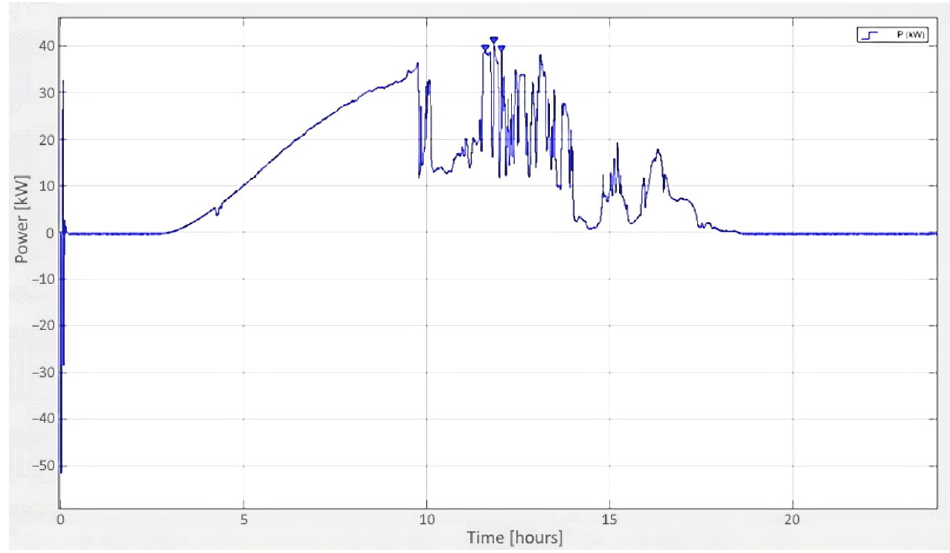
Figure 25. Daily waveform of the power supplied (39.65 kW) to the network on an exemplary day in July.